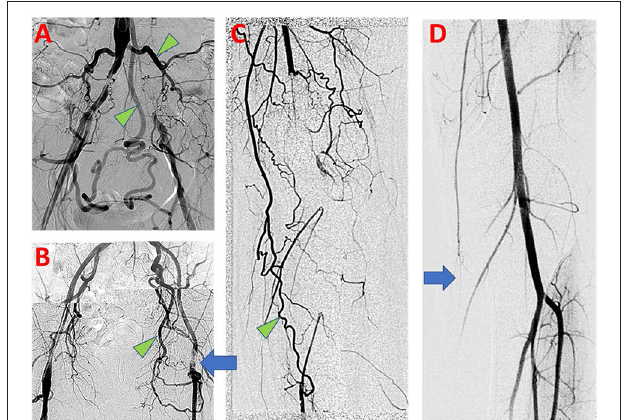
FIGURE 1 | Clinical findings of PAD in symptomatic patients. (A) Aortoiliac arteriogram demonstrates bilateral common iliac artery occlusive disease, with evidence of compensation by large lumbar and inferior mesenteric arterial collaterals (Green arrowhead). (B) Left common femoral artery occlusive disease (blue arrow) with prominent developed left obturator artery collateral (Green arrowhead). (C) Left lower limb popliteal artery occlusion with numerous collateral arteries, including developed branches of the descending genicular artery (Green arrowhead). (D) Normal left lower limb arteriogram shows small size and limited opacification of branches of the descending genicular artery at baseline (Blue